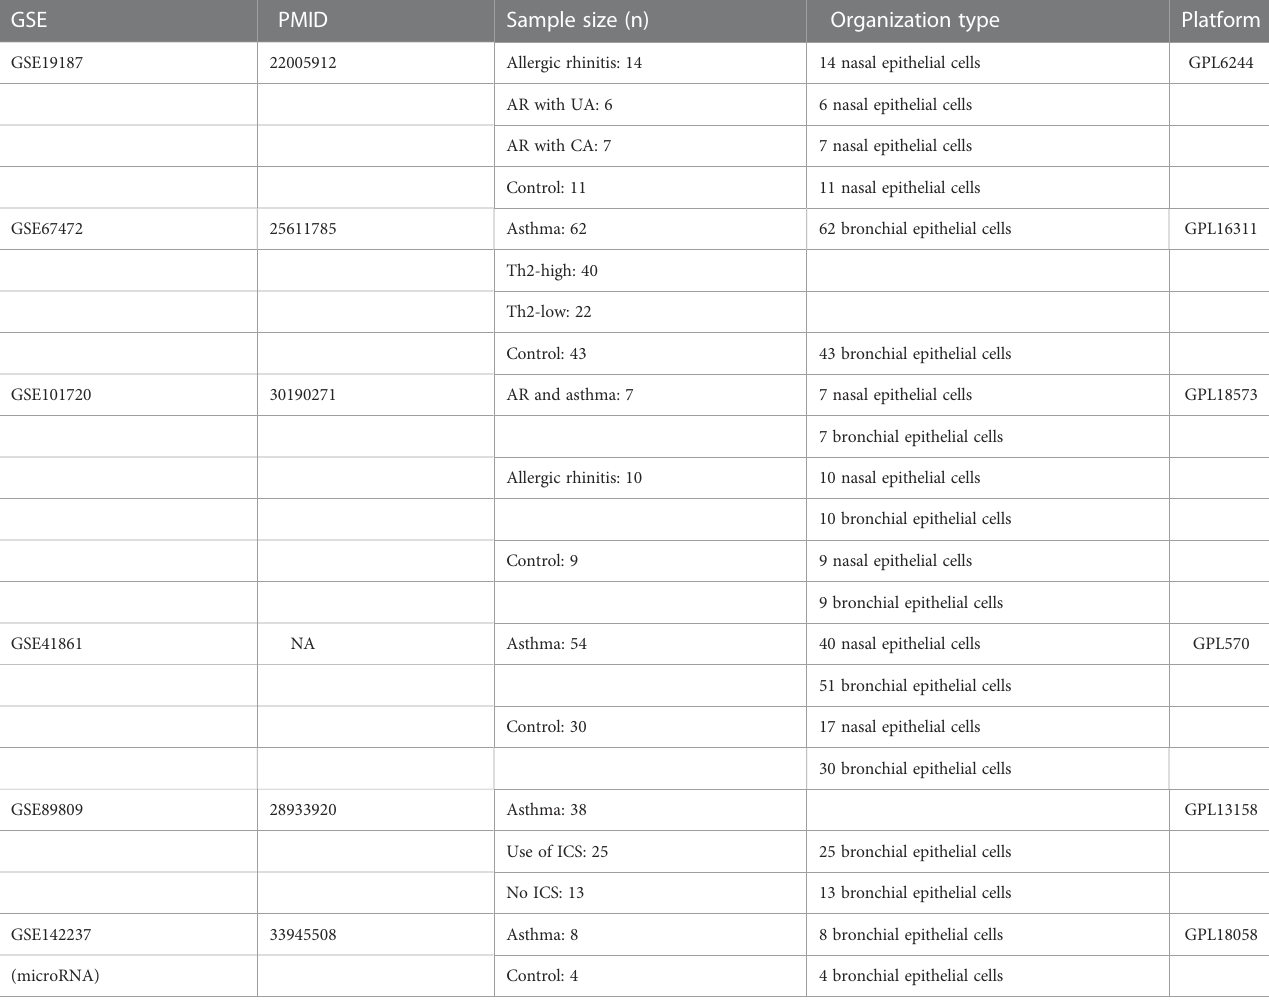
TABLE 1 The details of GEO datasets for the